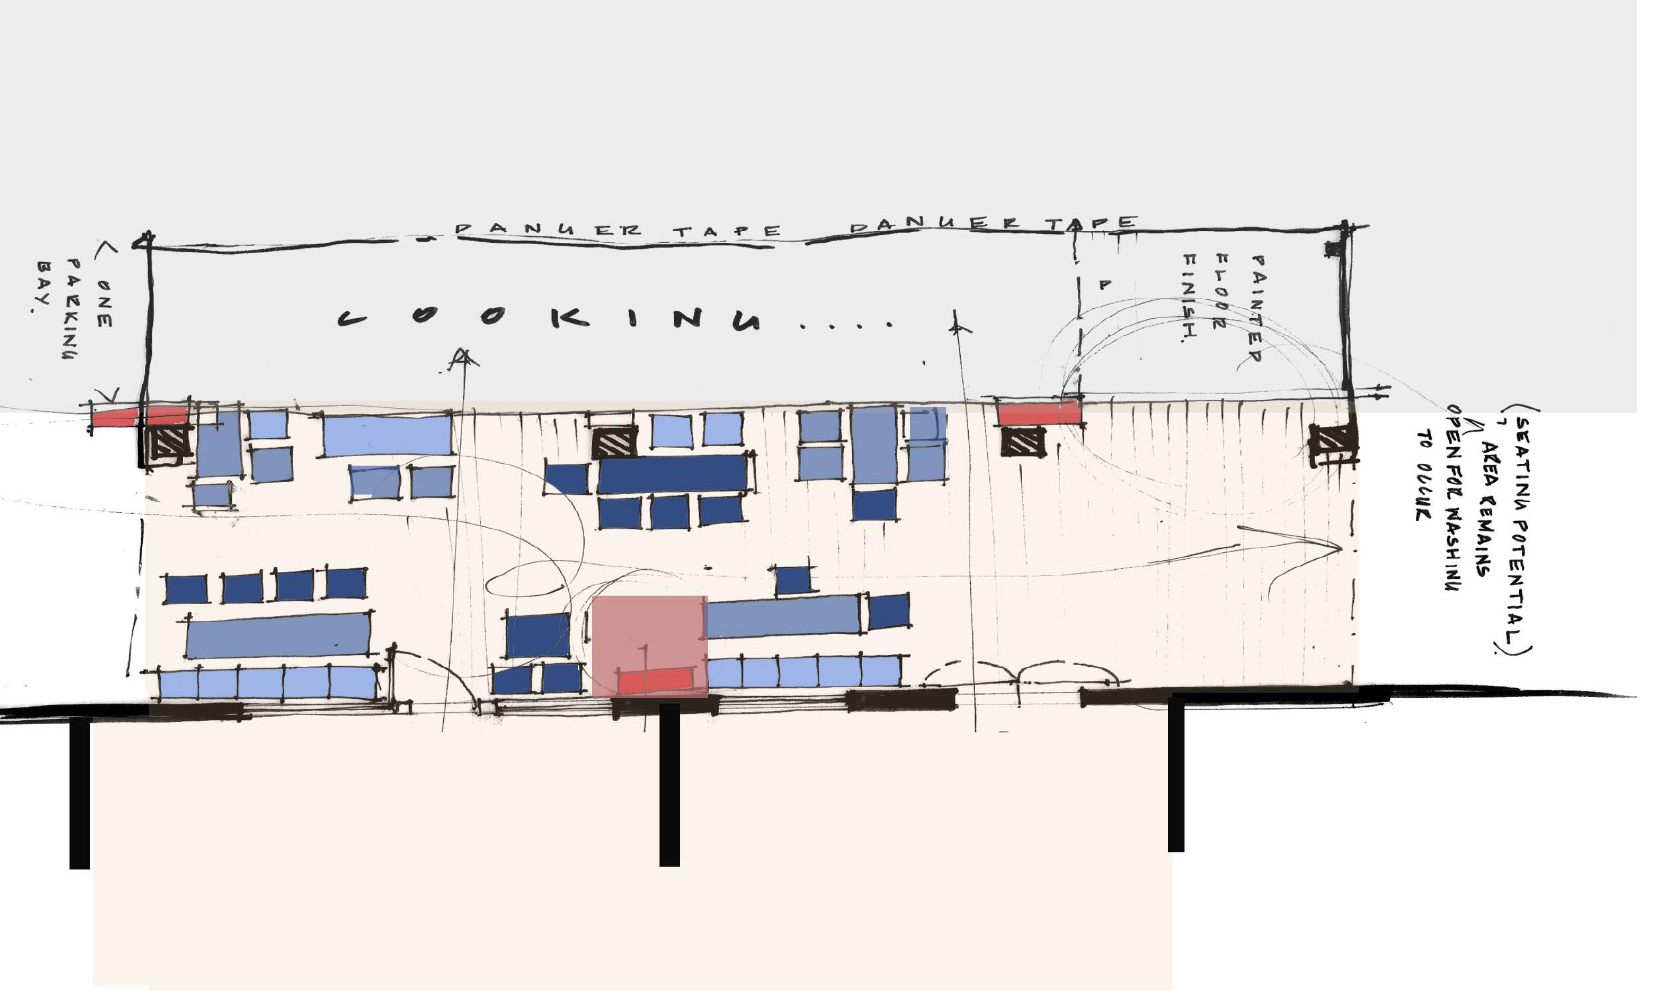
Photo: Katharina Rohde. Site-drawing: Sian Fisher.